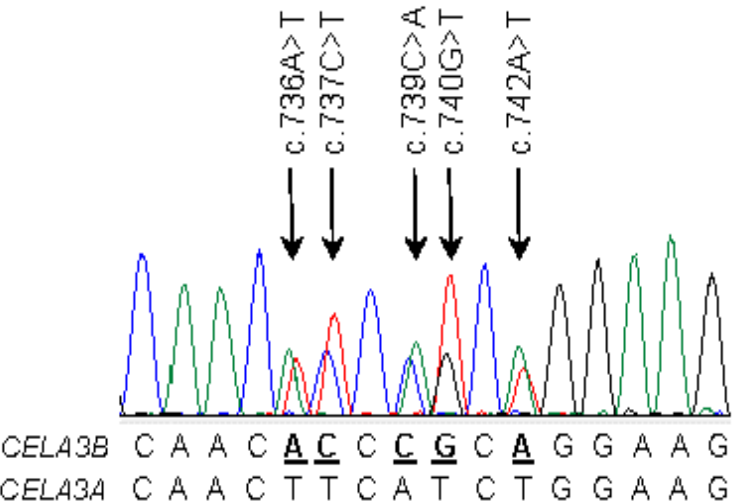
Figure 1. Gene conversion between CELA3A (donor) and CELA3B (acceptor). Electropherogram of CELA3B exon 7 in the Hungarian idiopathic chronic pancreatitis (ICP) patient. Heterozygous variations are indicated by arrows. Alignment of the relevant sequence tracts of CELA3A and CELA3B are also shown. CELA, human chymotrypsin-like elastase.